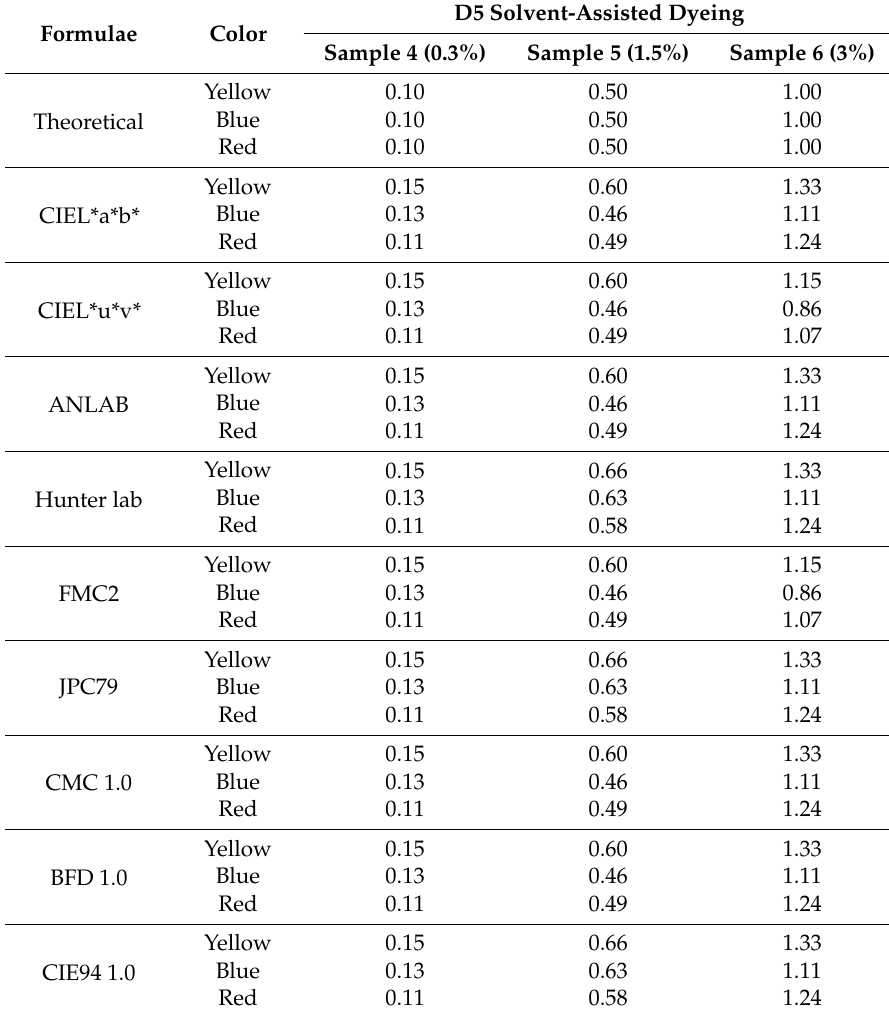
Table 7. Color matching recipes of solvent dyed standard samples with different color difference